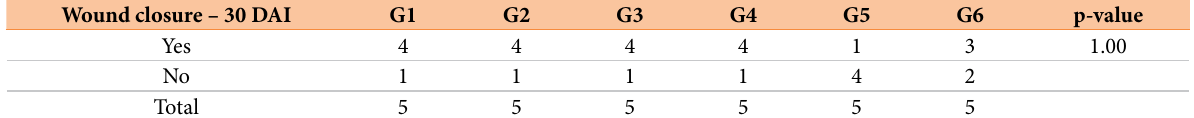
Table 4 - Wound closure of partial thickness burn wounds experimentally induced in Wistar rats treated with calcium and/or sodium alginate hydrogel-based dressings*.